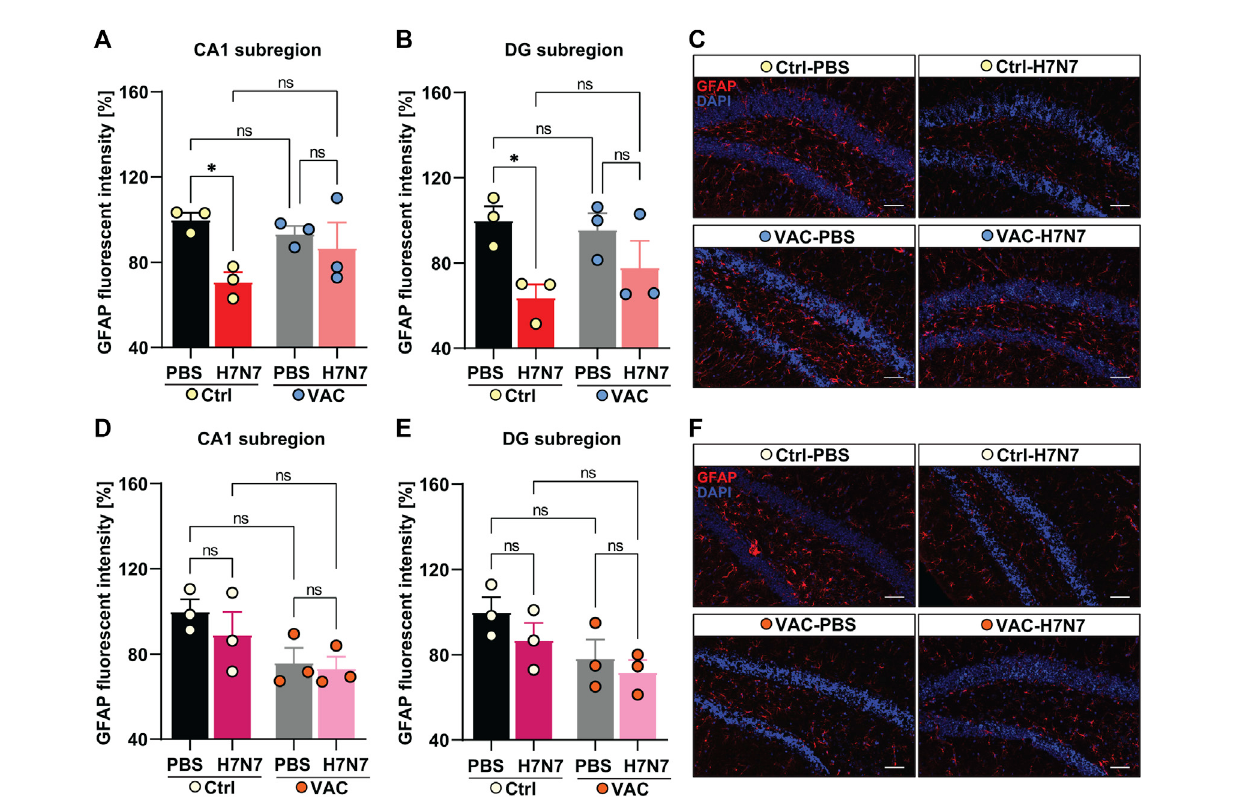
FIGURE 8 Effects of vaccination on hippocampal GFAP expression levels induced by H7N7 IAV infection. In young mice (A) GFAP expression in the CA1 subregion of the hippocampus was signi fi cantly decreased 8 days after H7N7 IAV infection in unvaccinated mice compared with the corresponding control. This decrease was not present in vaccinated mice after H7N7 IAV infection. Vaccination itself did not signi fi cantly decrease GFAP expression levels in CA1 ( n = 3 animals per group). (B) Infection with H7N7 IAV resulted in a signi fi cant decrease in GFAP expression levels in the dentate gyrus subregion in unvaccinated mice compared with the control group. This decrease was not observed after infection with the H7N7 IAV in previously vaccinated mice. Vaccination itself did not induce the signi fi cant changes in DG ( n = 3 animals per group). (C) Representative examples of GFAP immunostaining in the dentate gyrus subregion at 8 dpi (20X); scale = 50 μ m. In aged mice (D) , 10 days after H7N7 IAV infection, GFAP expression in the CA1subregionofthehippocampuswascomparablebetweenunvaccinatedinfectedandPBS-vaccinatedmice.GFAPexpressionwaslowerinvaccinated mice receiving PBS than in unvaccinated mice receiving PBS. However, infection with H7N7 IAV did not further decrease GFAP expression in vaccinated mice ( n = 3 animals per group). (E) In the DG subregion, H7N7 IAV infection in unvaccinated mice resulted in slightly decreased GFAP expression compared to corresponding control mice. GFAP expression was also reduced in this subregion of the hippocampus in vaccinated mice receiving PBS compared with unvaccinated mice receiving PBS. However, infection with H7N7 IAV did not further reduce GFAP expression in vaccinated mice ( n = 3 animals per group). (F) Representative examples of GFAP immunostaining in the dentate gyrus subregion at 10 dpi (20X); scale = 50 μ m. Data are presented as mean ± SEM and were analyzed with an ordinary two-way ANOVA followed by Fisher ’ s LSD test; * p < 0.05, ** p < 0.01, and ** p <